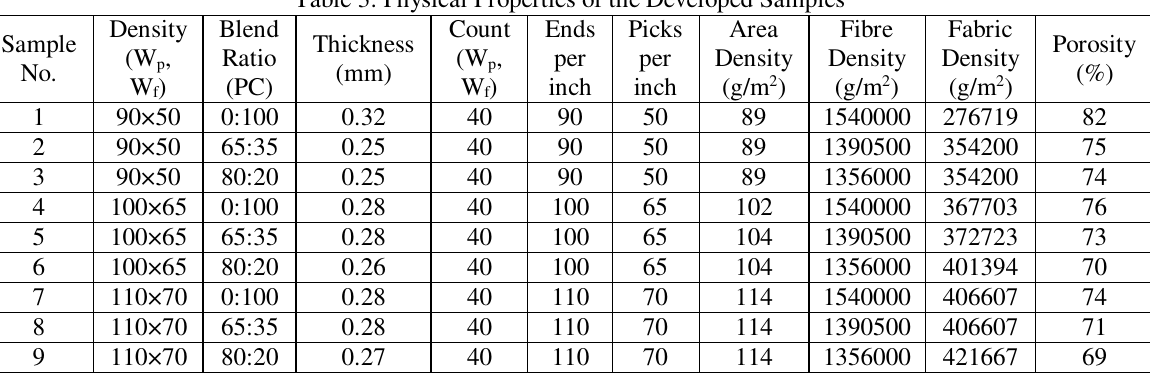
Table 3: Physical Properties of the Developed